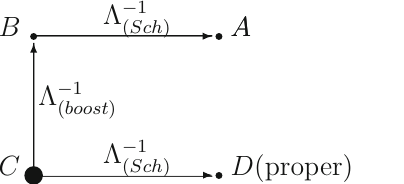
Fig. 2 A schematic representation of various pairs of the tetrad and spin connection in the Lemaitre gauge. The bold dot represents the initial tetrad (6.1) in which we “switch off” gravity